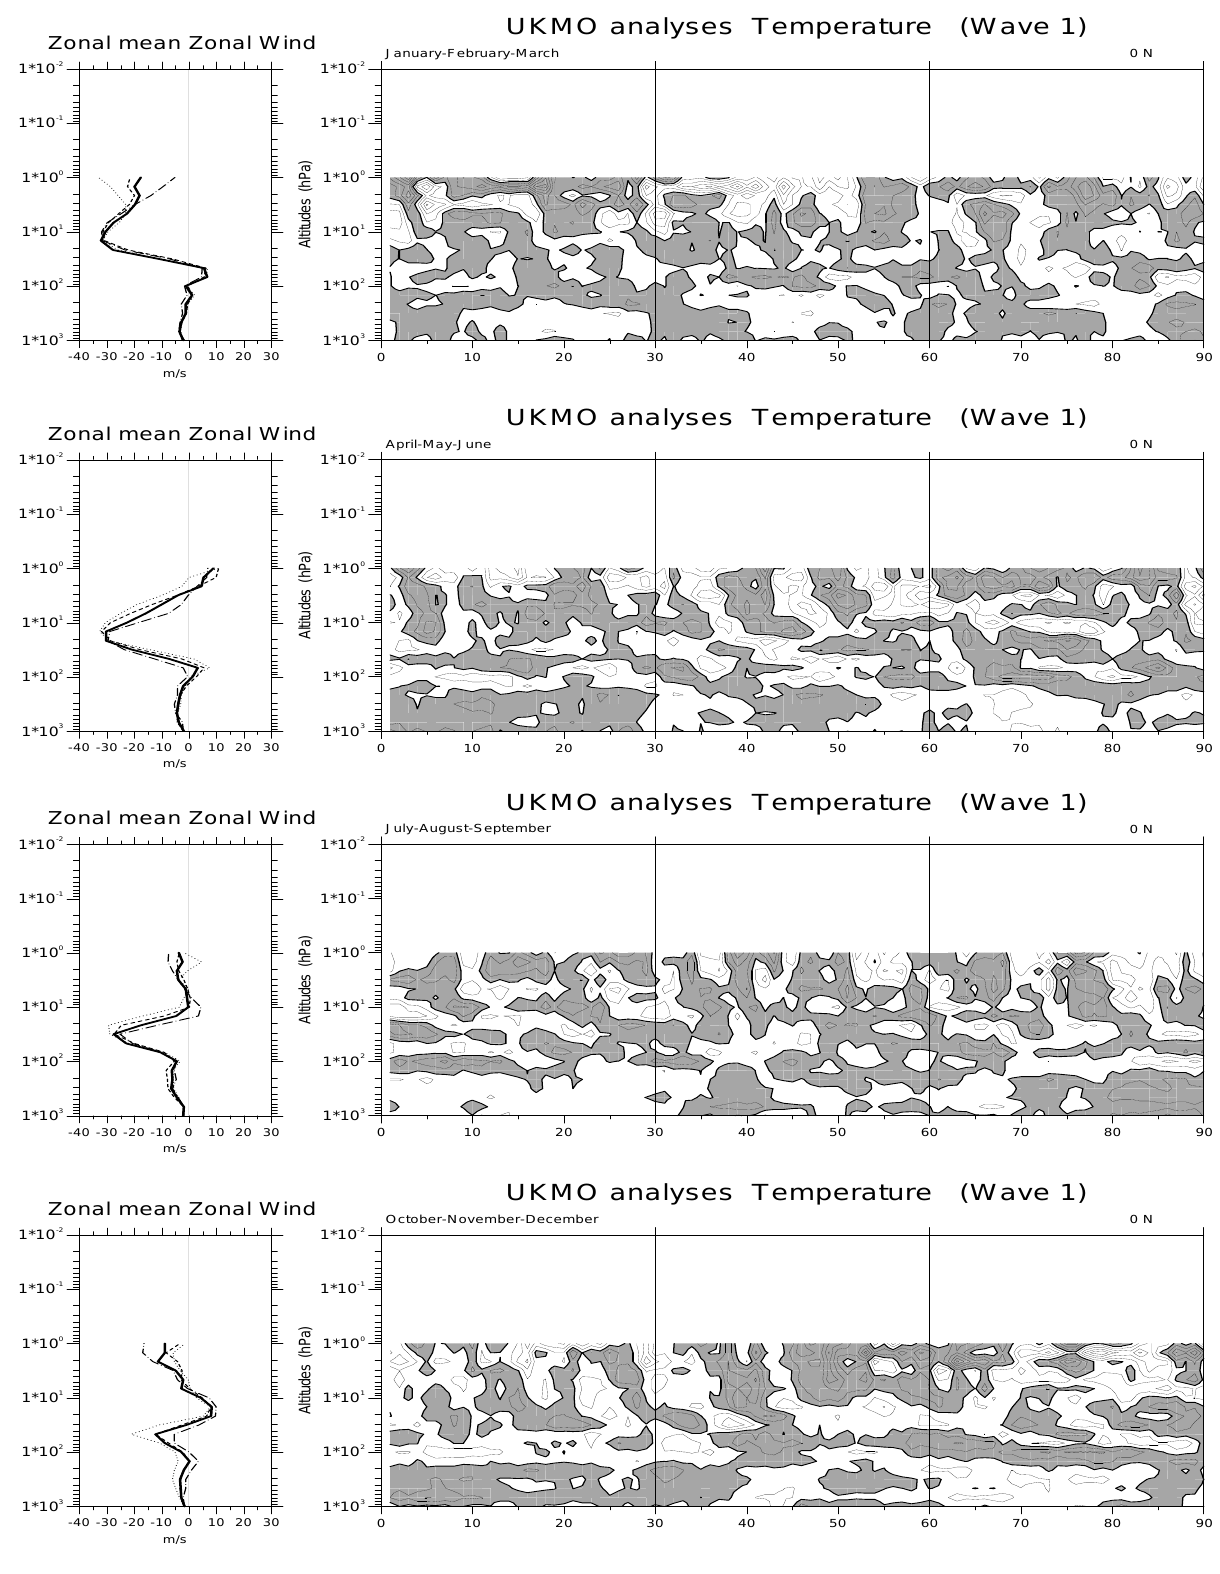
Fig. 3. Time-height section of temperature zonal wave 1 over the equator at 0 ◦ longitude for the UK Met Office assimilated data for the year 1994. Positive values are shaded and the contour interval is 0.5 K. The solid lines of the left panel show the zonal wind averaged over the 3 months of the right panels; dotted lines correspond to the first month, dashed lines to the second month and dash-dotted lines to the third